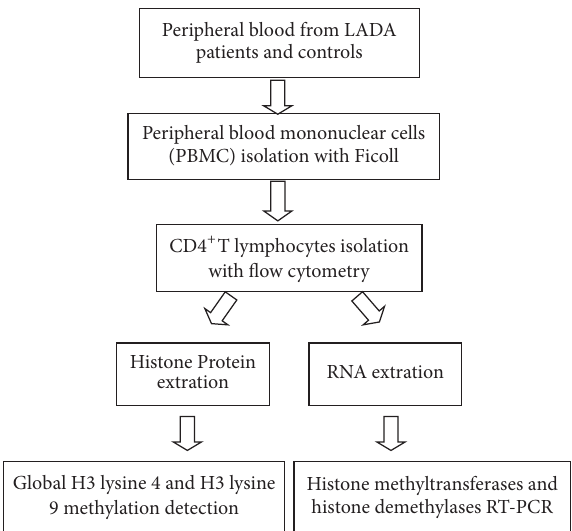
Figure 1: The study scheme. Twenty-six LADA patients and 26 healthy control subjects were enrolled in this study. Peripheral blood mononuclear cells (PBMC) were isolated with Ficoll from peripheral venous blood which was obtained from each participant. CD4 + T lymphocytes were isolated by flow cytometry. Then, Global H3 lysine 4 and H3 lysine 9 methylation was detected in CD4 + T lymphocytes from 26 subjects. The mRNA level of histone methyltransferases gene (SET1, SUV39H1, SUV39H2, and G9a) and histone demethylases gene (LSD1, KDM3A, KDM4A, KDM4B, KDM4C, KDM5A, KDM5B, KDM5C, and KDM5D) was detected by real-time